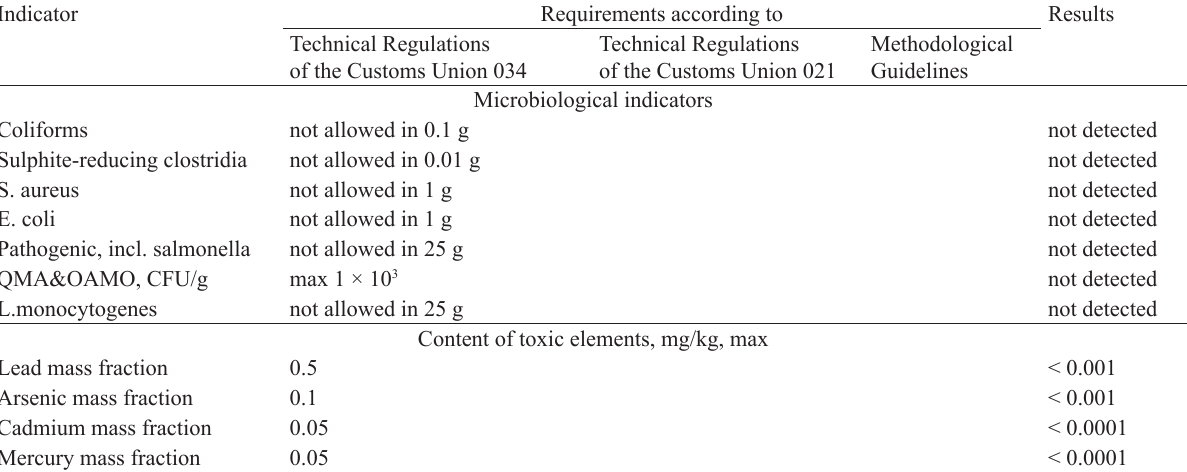
Table 3 Safety indicators for restructured poultry products containing dietary fibres Indicator